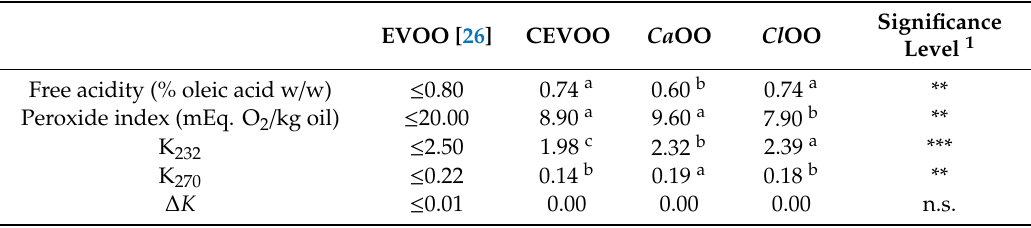
Table 4. Chemical characterization of the control (CEVOO), Citrus x aurantium peel olive oil ( Ca OO), Citrus limon peel olive oil ( Cl OO) and EVOO legal limits Regulation [26]. EVOO [26]